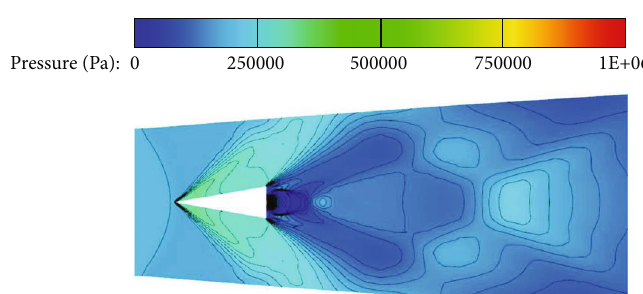
Figure 12: Distribution of pressure.